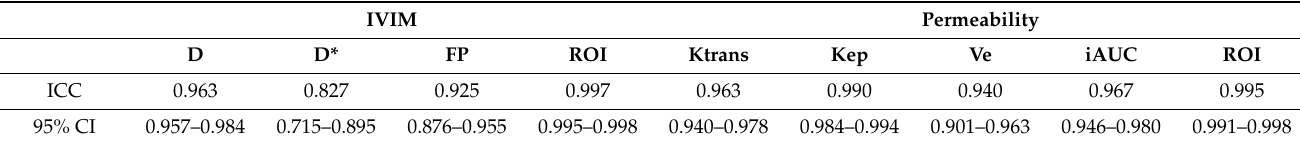
Table 3. Results of the ICC analysis.